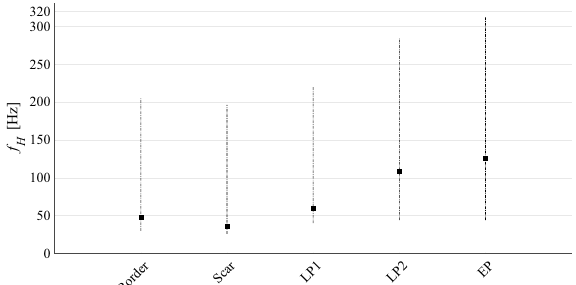
Figure 2. Distribution of the frequency values f H including 95% of the total PSD power for each EGM type. Distributions of frequency limits f H are reported as medians (squares) and 5th and 95th